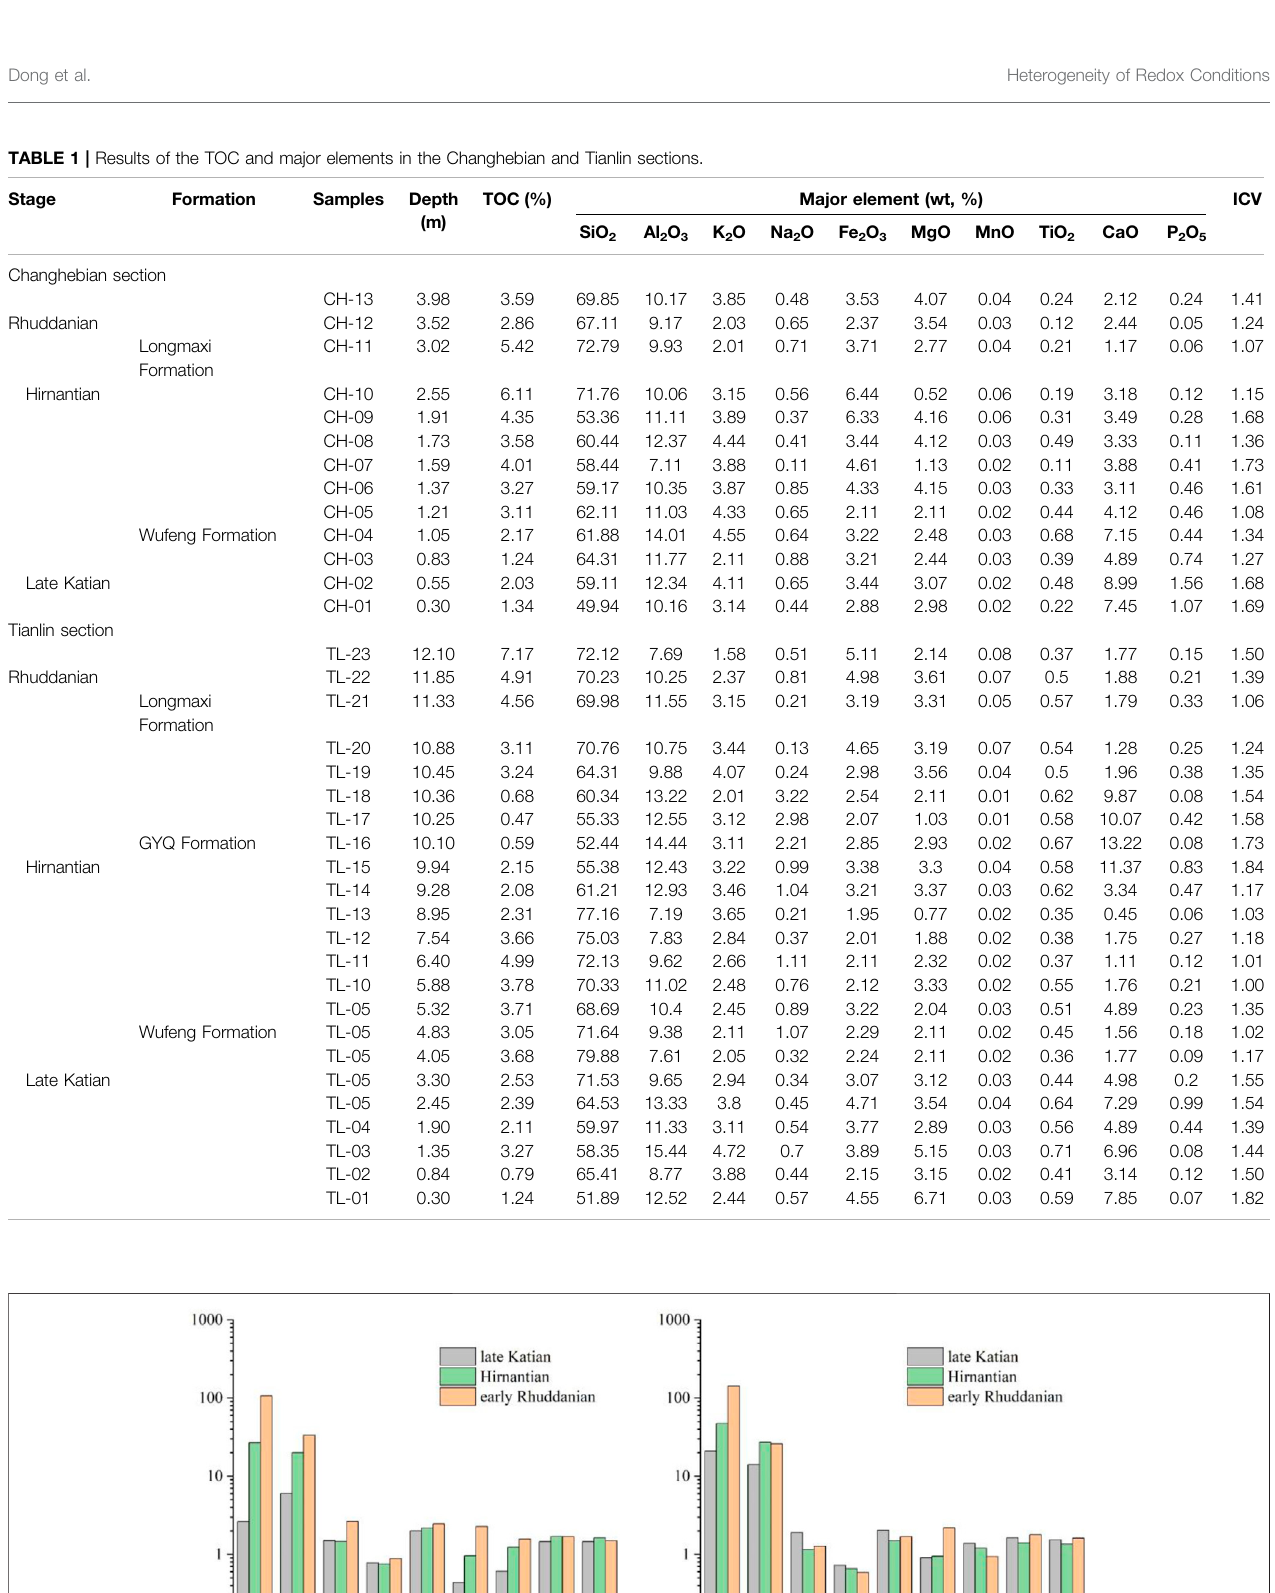
Frontiers in Earth Science |